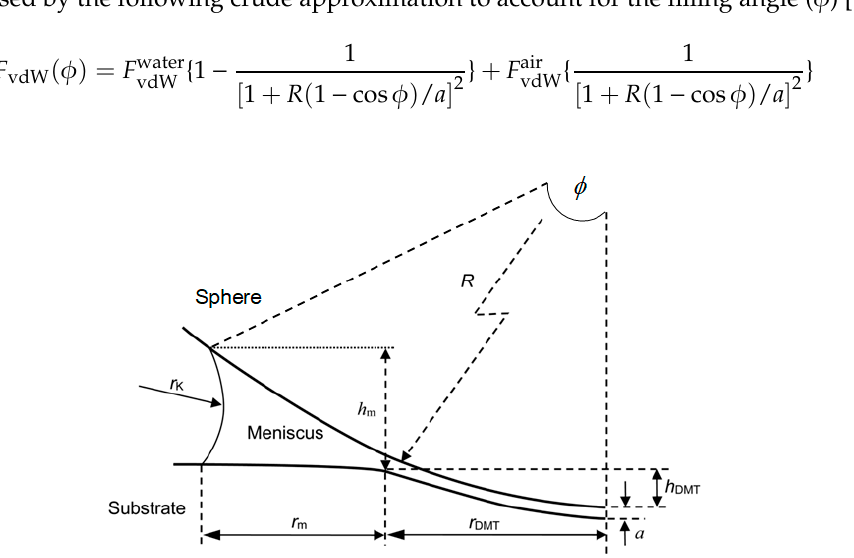
Figure 11. A geometric model of a liquid meniscus formed between a sphere and a flat substrate. Here, φ is the filling angle, R the sphere radius, h DMT the DMT indentation depth, h m the height of meniscus, r K the Kelvin radius (or meridional radius) of meniscus, r m the meniscus-only portion of the total radius from the contact center, and r DMT the DMT contact radius. Reprinted from Ref. [91], Copyright 2017, with permission from ACS publications.